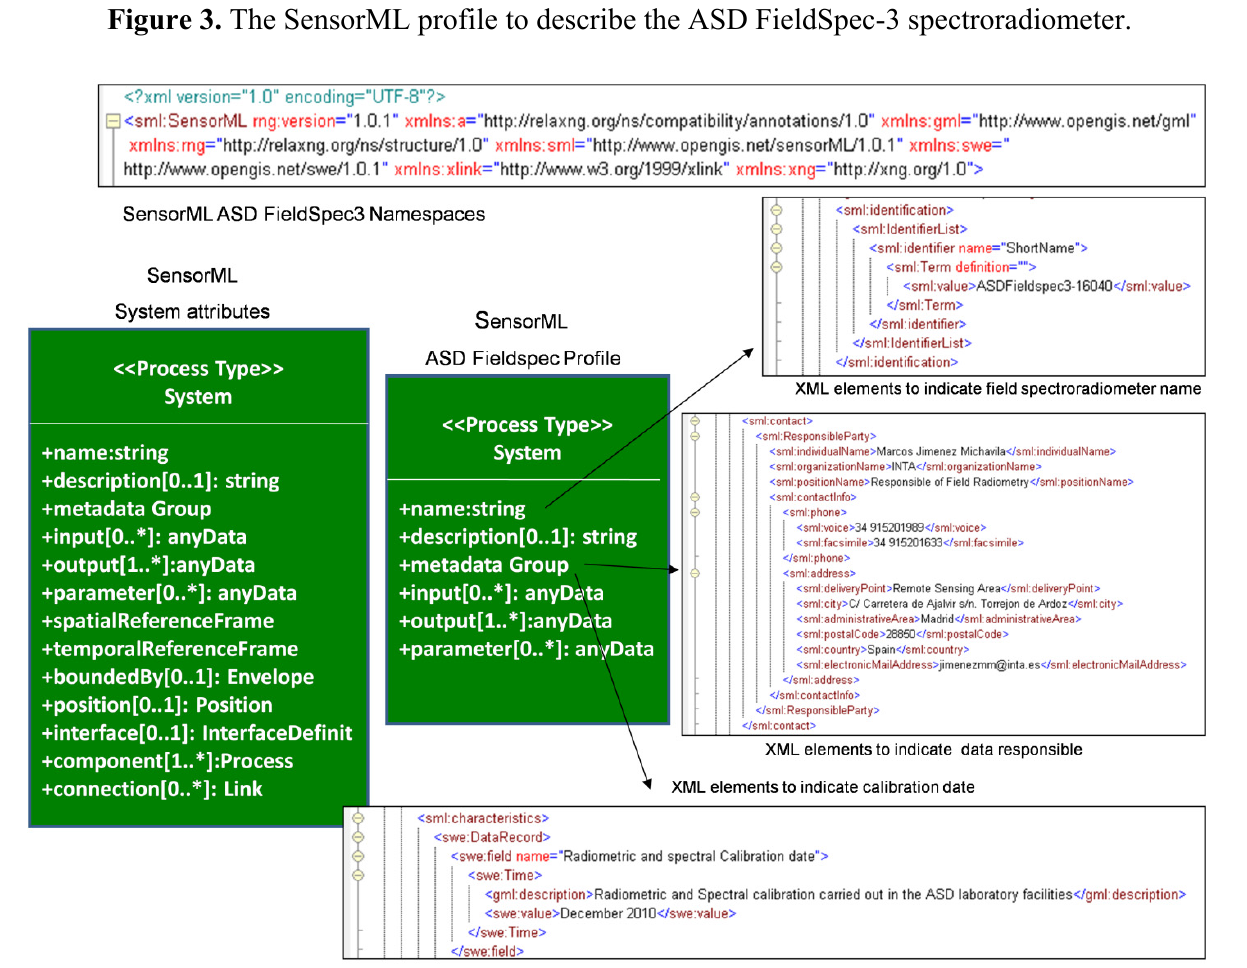
Figure 3. The SensorML profile to describe the ASD FieldSpec-3